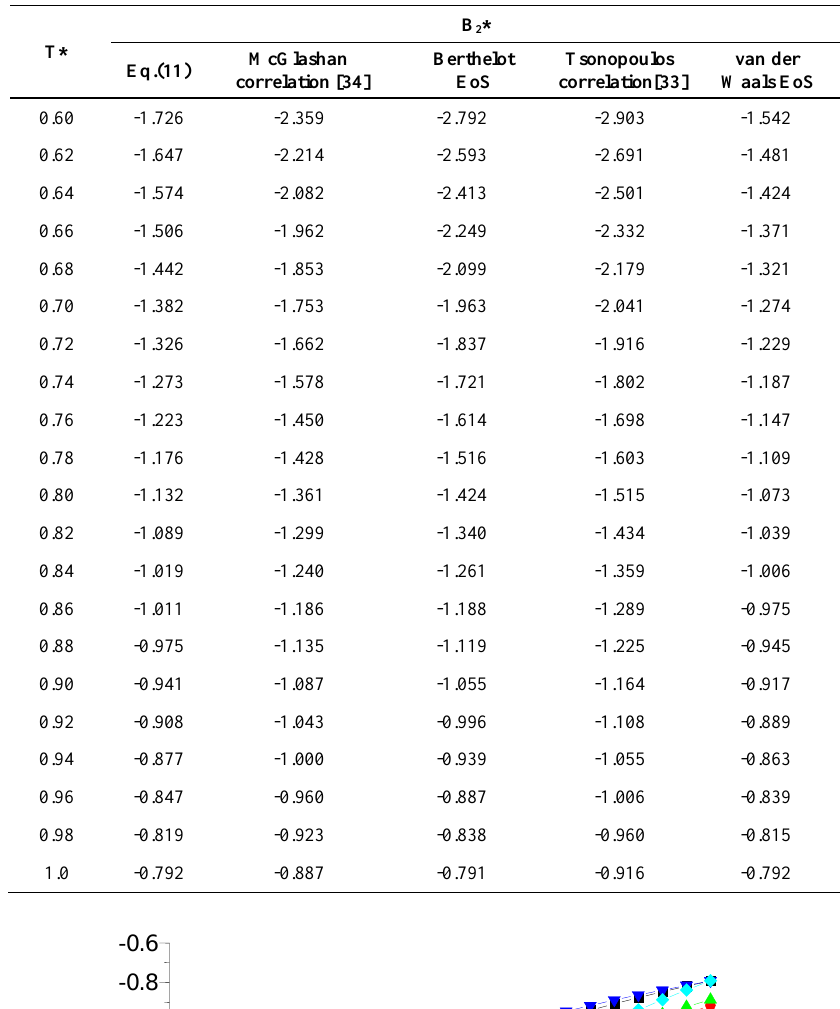
Table 2. Second virial coefficient of gold